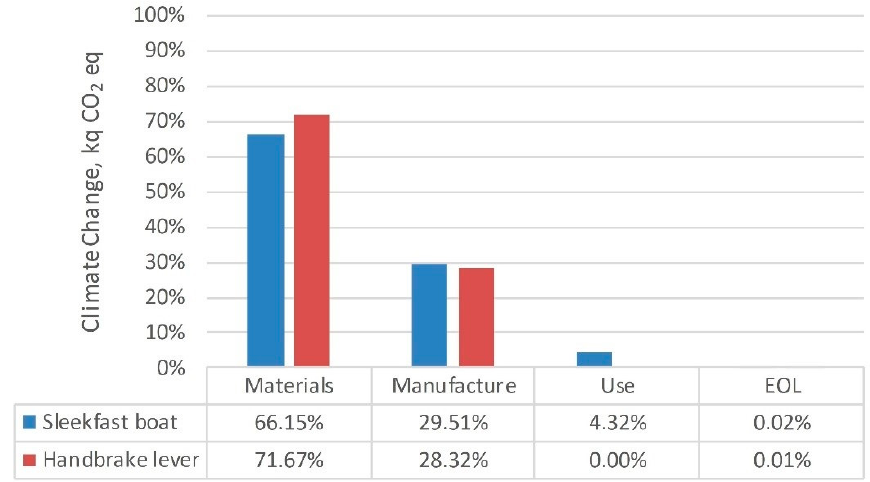
Figure 5. Percent contribution of life cycle stages to the total impact for the two case studies: composite Sleekfast sailing boat and handbrake lever.